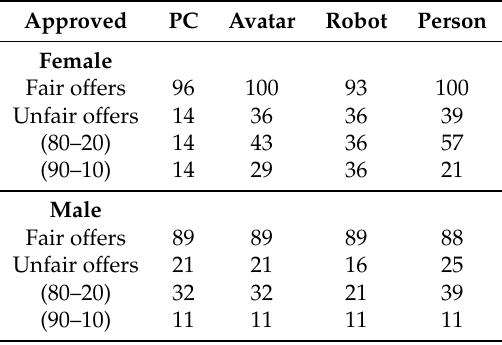
Figure 5. The GSR signals from P1 of unfair rejected offers (game 2 and 6) and fair accepted offers (4 and 8) ( top ). Log of game 2 ( bottom ). Table 2. Gender differences of unfair offers accepted per